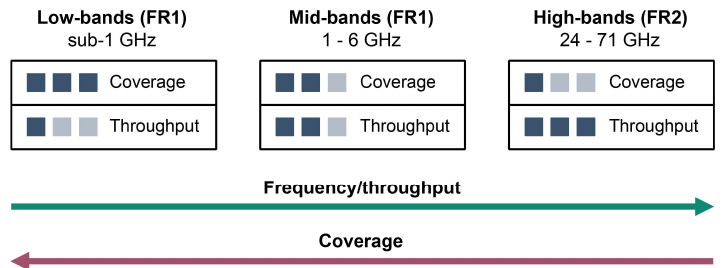
Figure 2. Frequency bands in the 5G networks.